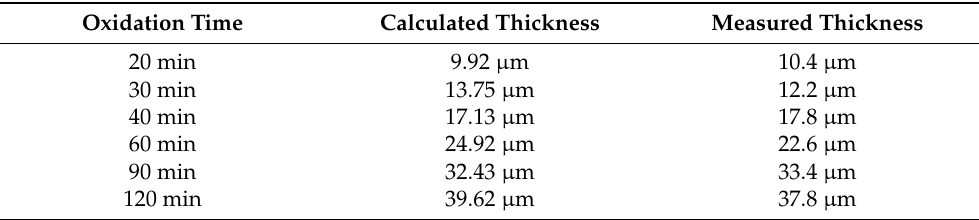
Table 3. Calculated and measured film thickness with different oxidation time.